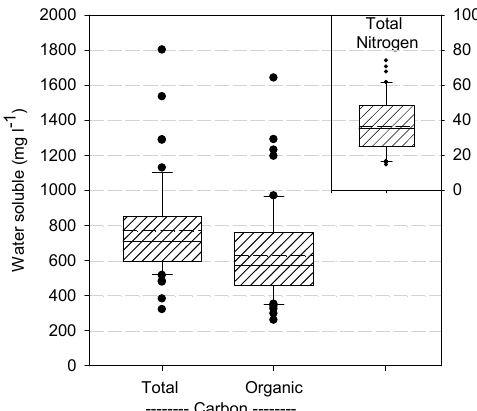
Figure 3. The mean and range of water-soluble total and organic carbon, and water-soluble total nitrogen (inset), taken from the aqueous extraction of a subset of surveyed urban soils ( n = 52). The dashed line is the mean value, the solid line is the median, the box represents the upper and lower quartiles, and the whiskers are the 10th and 90th percentiles.